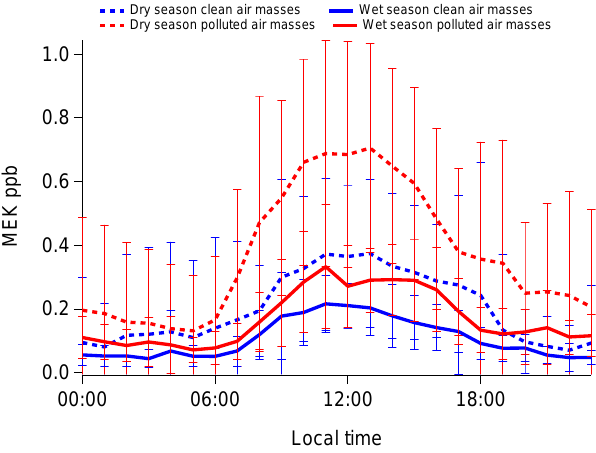
Figure 7. Hourly average concentrations of MEK in ppb for the clean conditions (blue) and the polluted conditions (red) at the T2 site. Dashed lines represent the dry season and thick lines represent the wet season. Error bars represent the standard